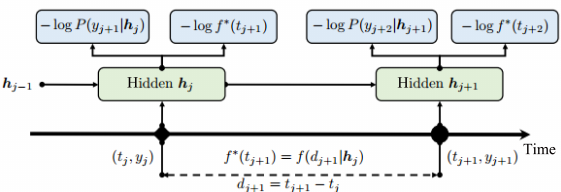
Fig. 17 Two consecutive time slices in the hidden layer of the recurrent marked temporal point process [63]